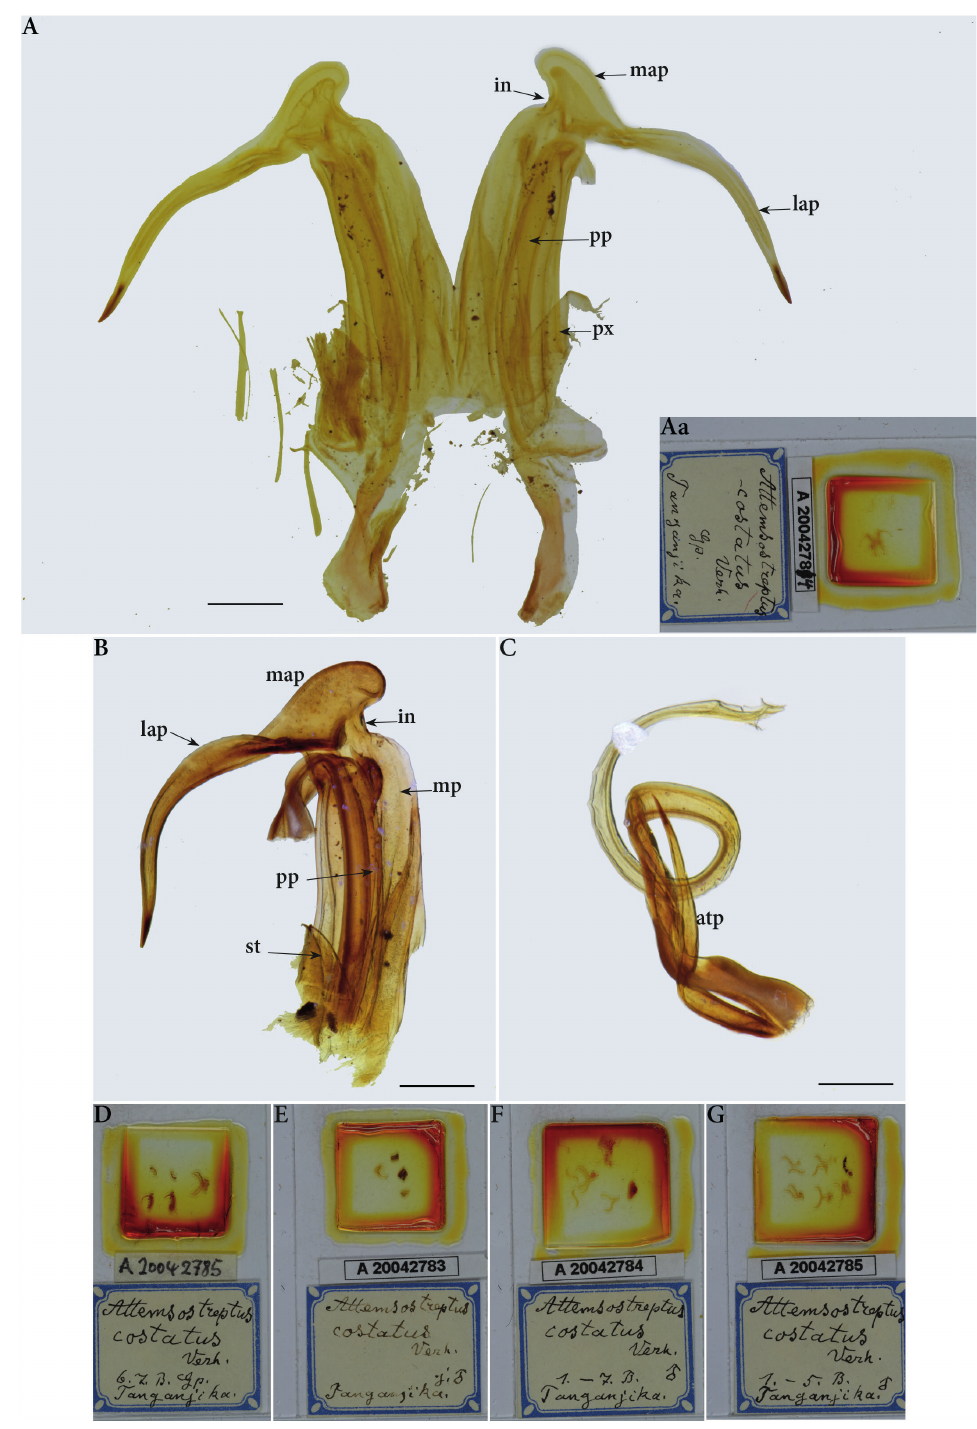
Fig. 1. Attemsostreptus costatus Verhoeff, 1941, type material ZSM. A . Gonopods, anterior view. Aa . Overview of slide A 200427814, containing the gonopods. B . Slide A20042785, left gonopod, anterior view. C . Telopodite. D–G . Overview of Verhoeff’s slides (ZSM) A20042785, A20042783, A20042784, A20042785. For abbreviations, see Material and methods. Aa, D–G photo credit J. Spelda. Scale bars: A–C = 0.5 mm; Aa, D–G: images not to